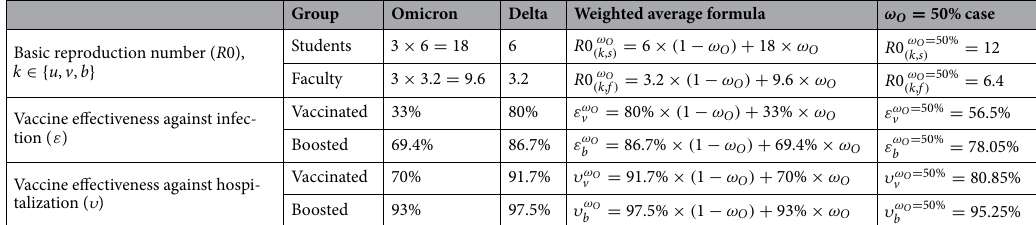
Table 3. Weighted average computations for the basic reproduction number and vaccine effectiveness values when the proportion of infections caused by Omicron (Delta) is ω 0 ( 1 − ω 0